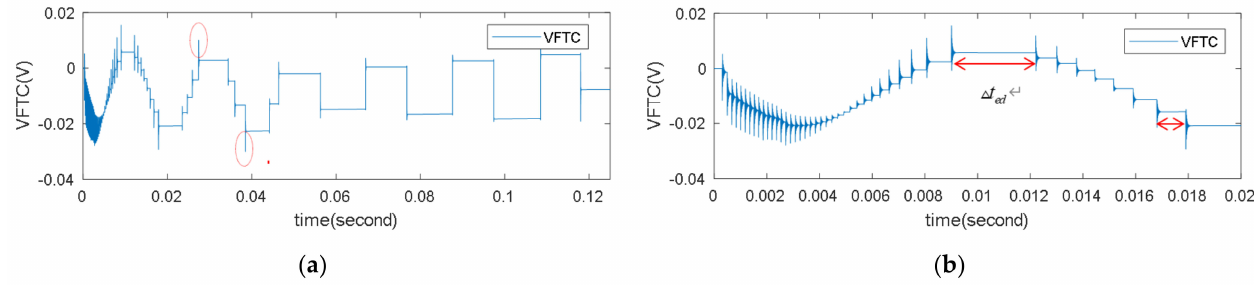
Figure 13. VFTC waveforms in the whole process at the output of active integrator (S. No3). ( a ) VFTC waveforms; ( b ) the expansion of VFTC waveforms.